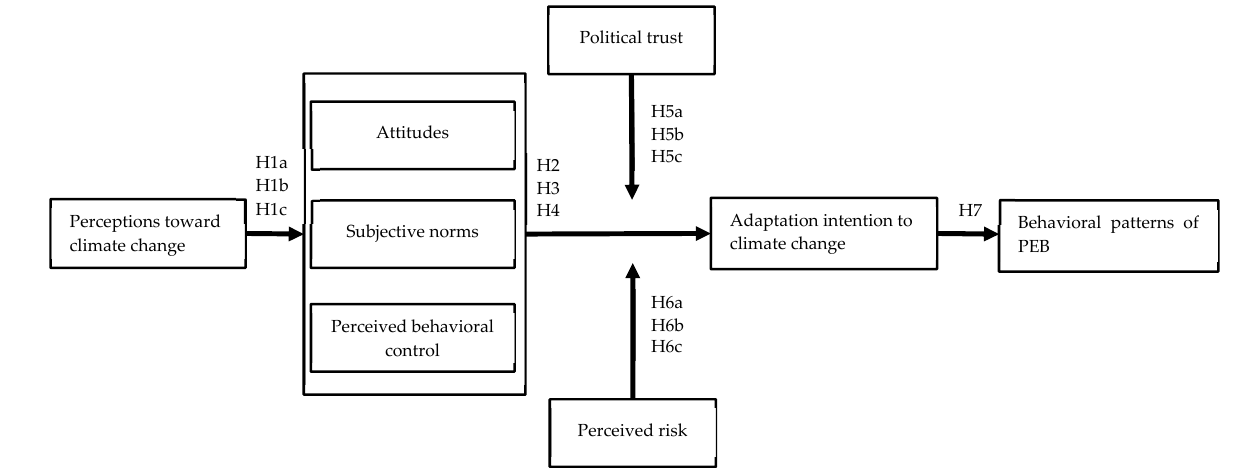
Figure 1. Predictors of behavioral patterns of PEB.